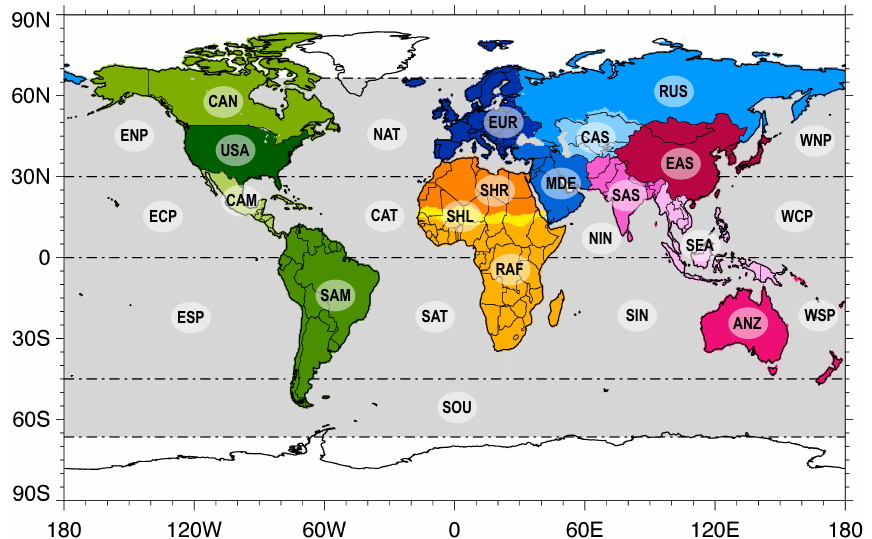
Fig. 1. Land and ocean region domains defined in this study. Region description, abbreviation, and surface area listed in Table 1. Regions with names in the circles are discussed in the